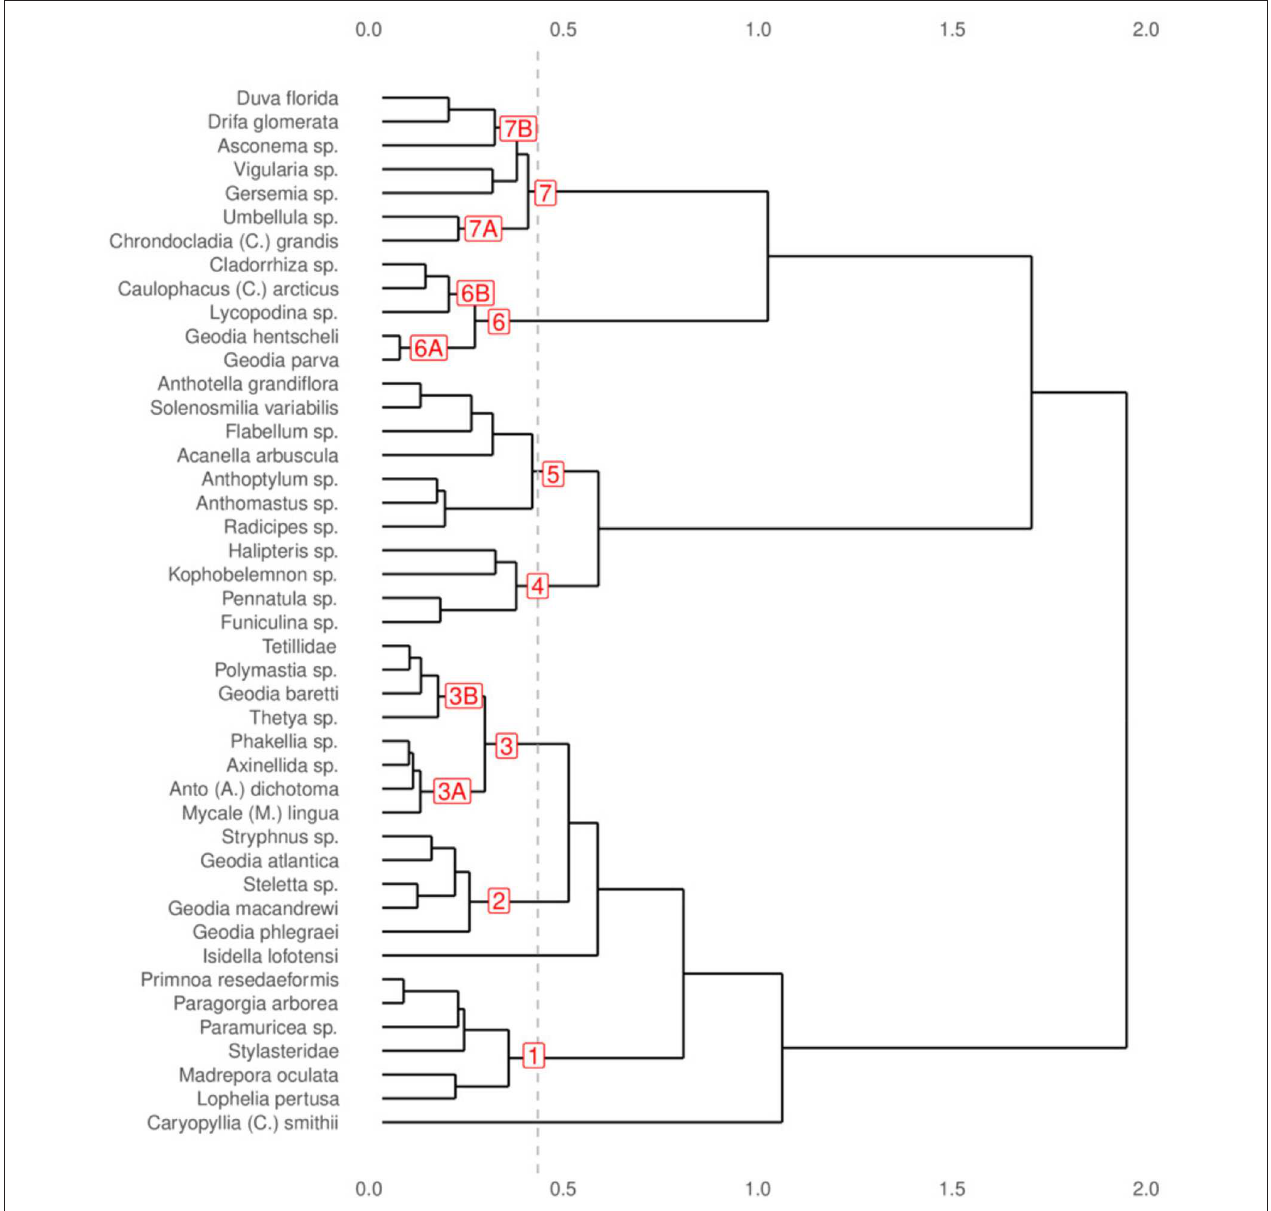
FIGURE 3 | Dendrogram of the predicted distribution of 44 VME indicator taxa, based on a cluster analysis (Ward method) of the complement of the “I” similarity statistic computed among all predicted distributions. Red labels indicate the seven groups identified at the 0.4 dissimilarity value, and the six sub-groups identified by examining the distribution patterns of taxa in each